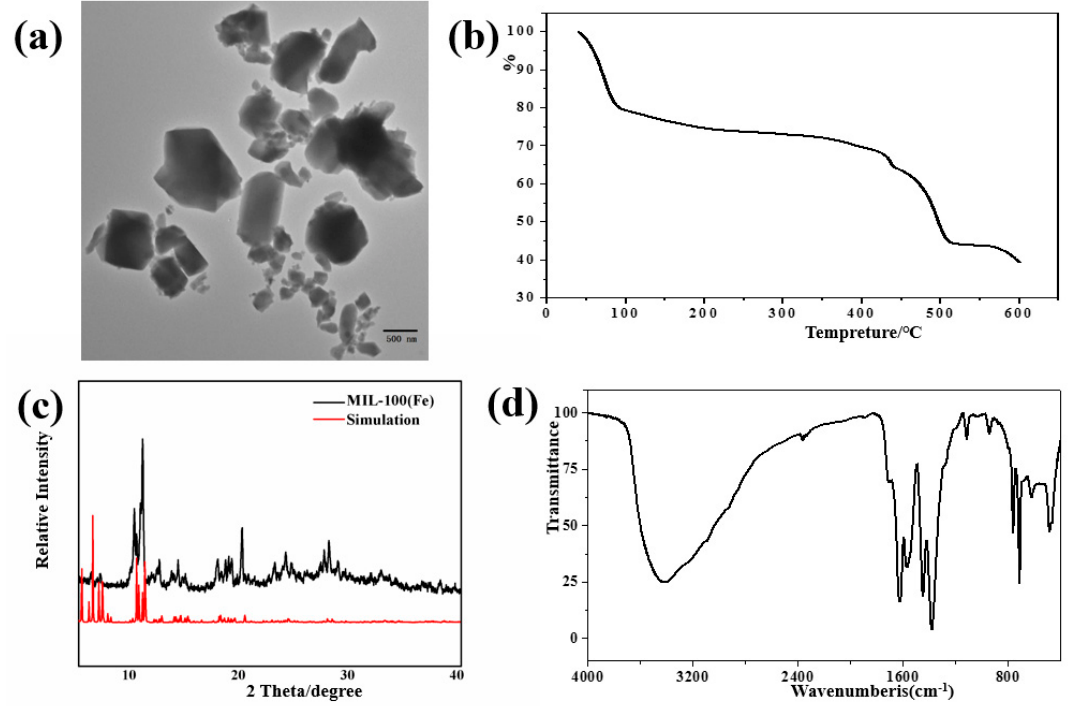
Figure 2. Characteristics of MIL-100(Fe): ( a ) TEM, ( b ) TG, ( c ) XRD, ( d ) FTIR.